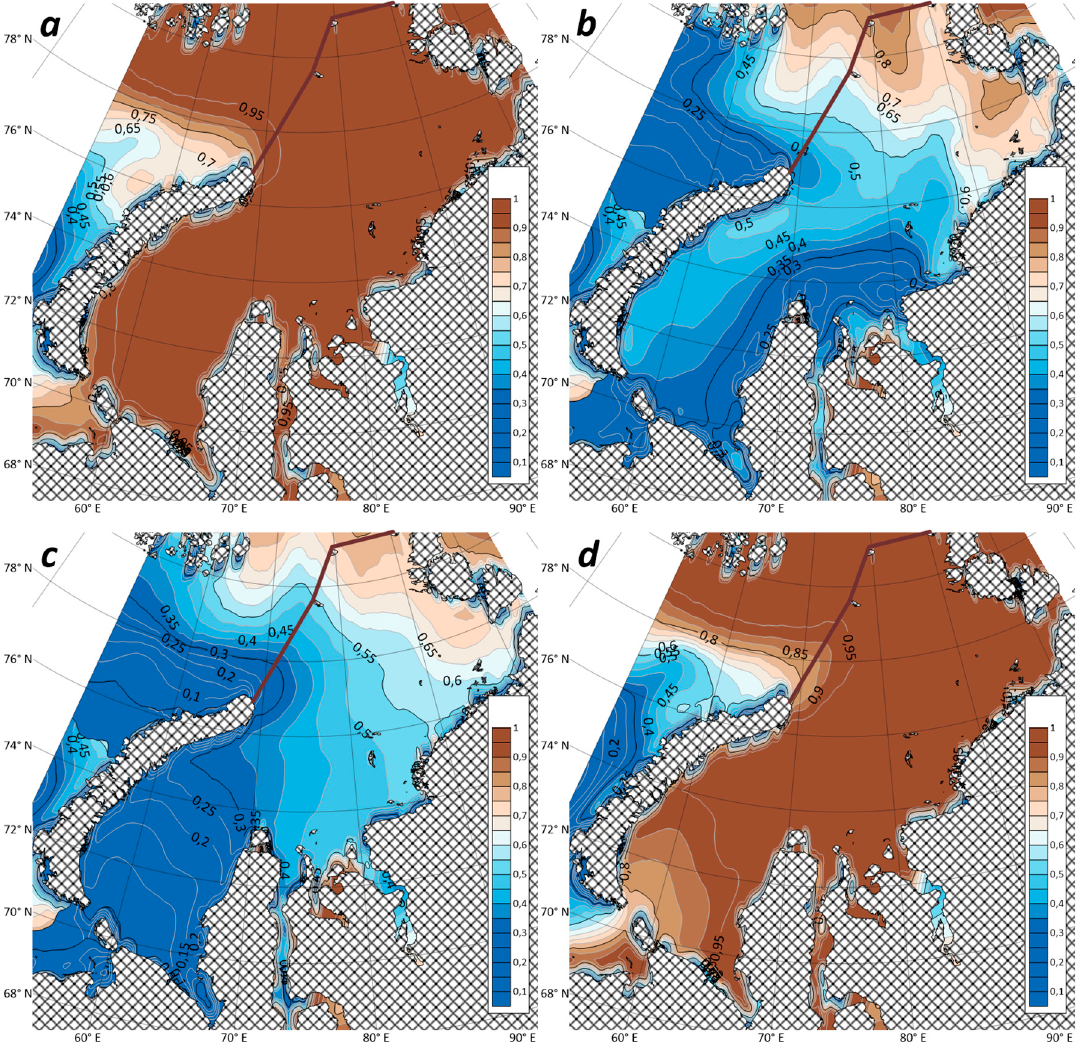
Figure 9. The probability of the presence of ice with a concentration of more than 50% in the Kara Sea according to reanalysis data (in 0–1 unit) for the periods: MAM ( a ), JJA ( b ), SON ( c ), DJF ( d ).